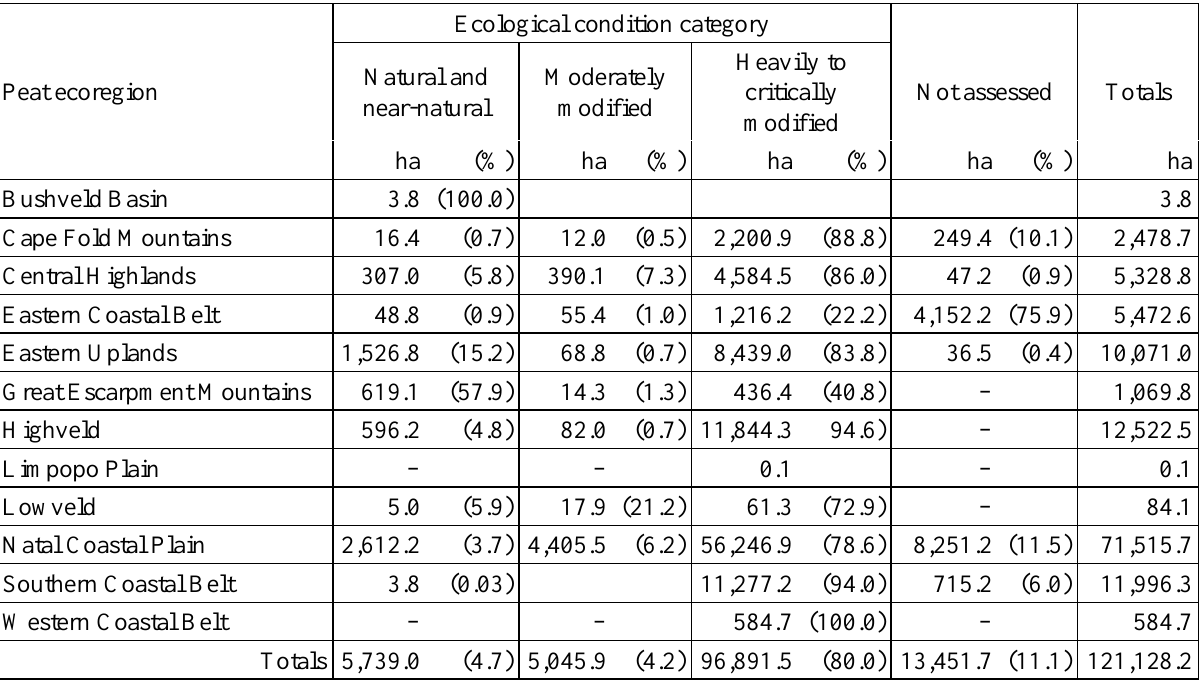
Table 4. Areal extent and areal percentage of peatlands according to peat ecoregion and ecological condition.